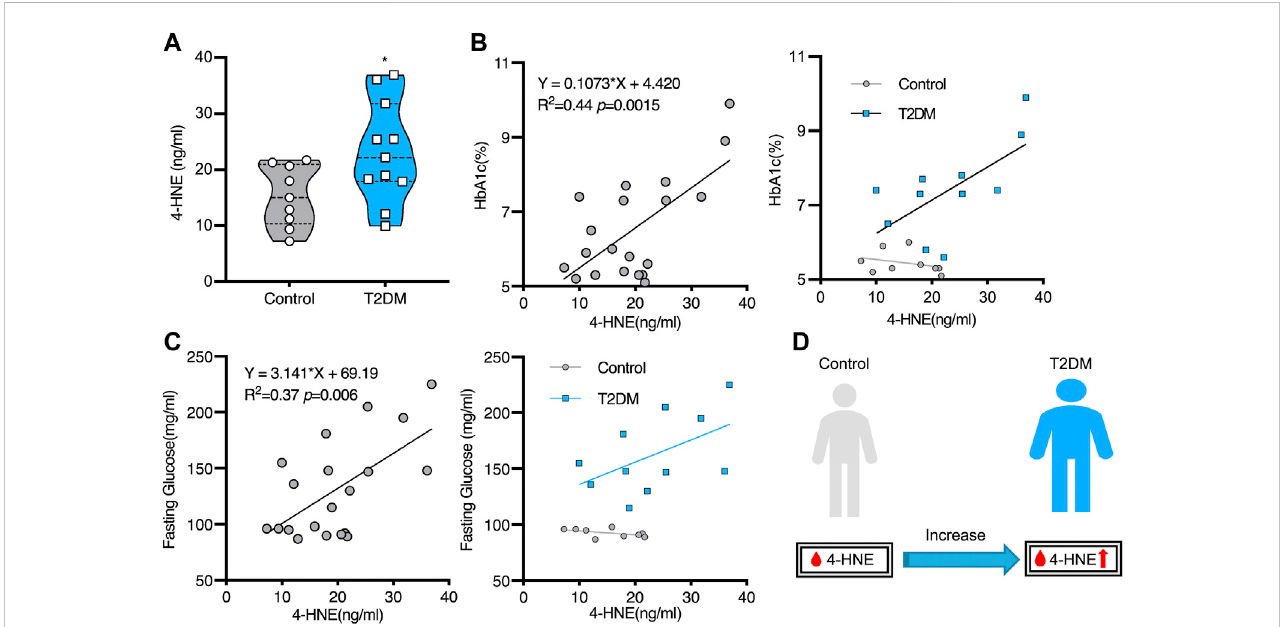
Increased serum hydroxynonenal (4-HNE) level in the patients with type 2 diabetes (T2DM) Panel (A) The serum 4-HNE level was signi fi cantly higher in T2DMpatients,comparedtothenon-diabeticsubjects(Control).Panels (B) and (C) Thesimplelinearanalysisshowsthattheserum4-HNElevelwaspositively correlatedwithHbA1c (B) andfastingglucose (C) .Panel (D) Theserum4-HNElevelwascloselyrelatedtotheoccurrenceofT2DM.Reprintedwithpermission from Lou et al.